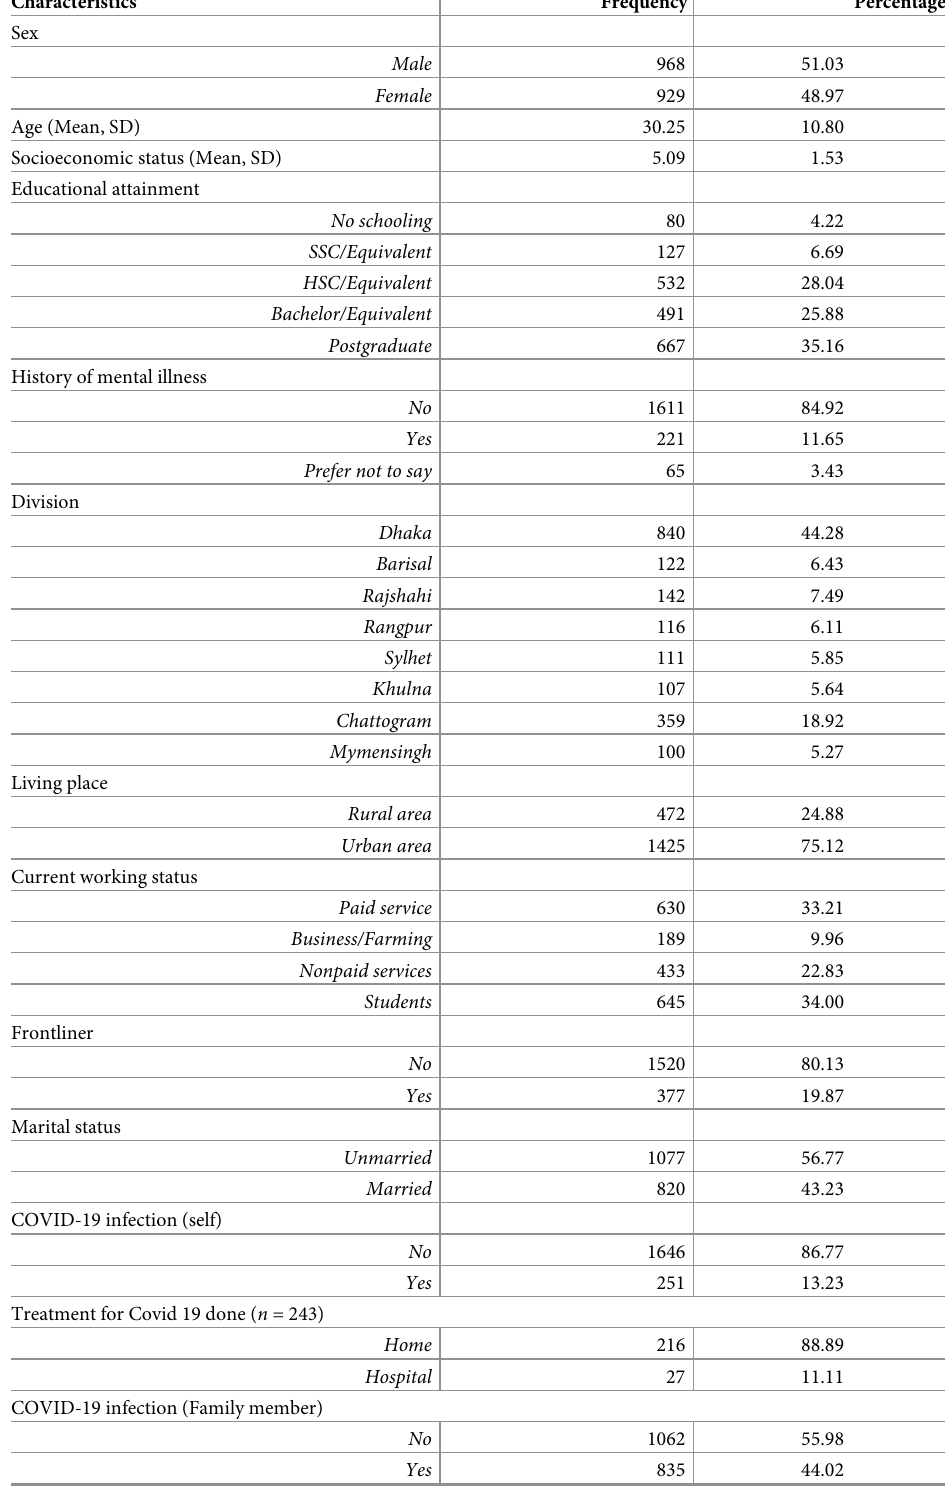
Table 1. Sample characteristics ( N =